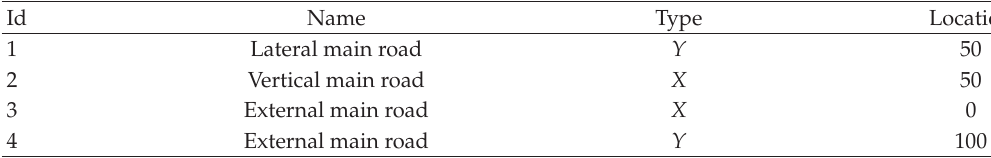
Table 3: Key control line properties.